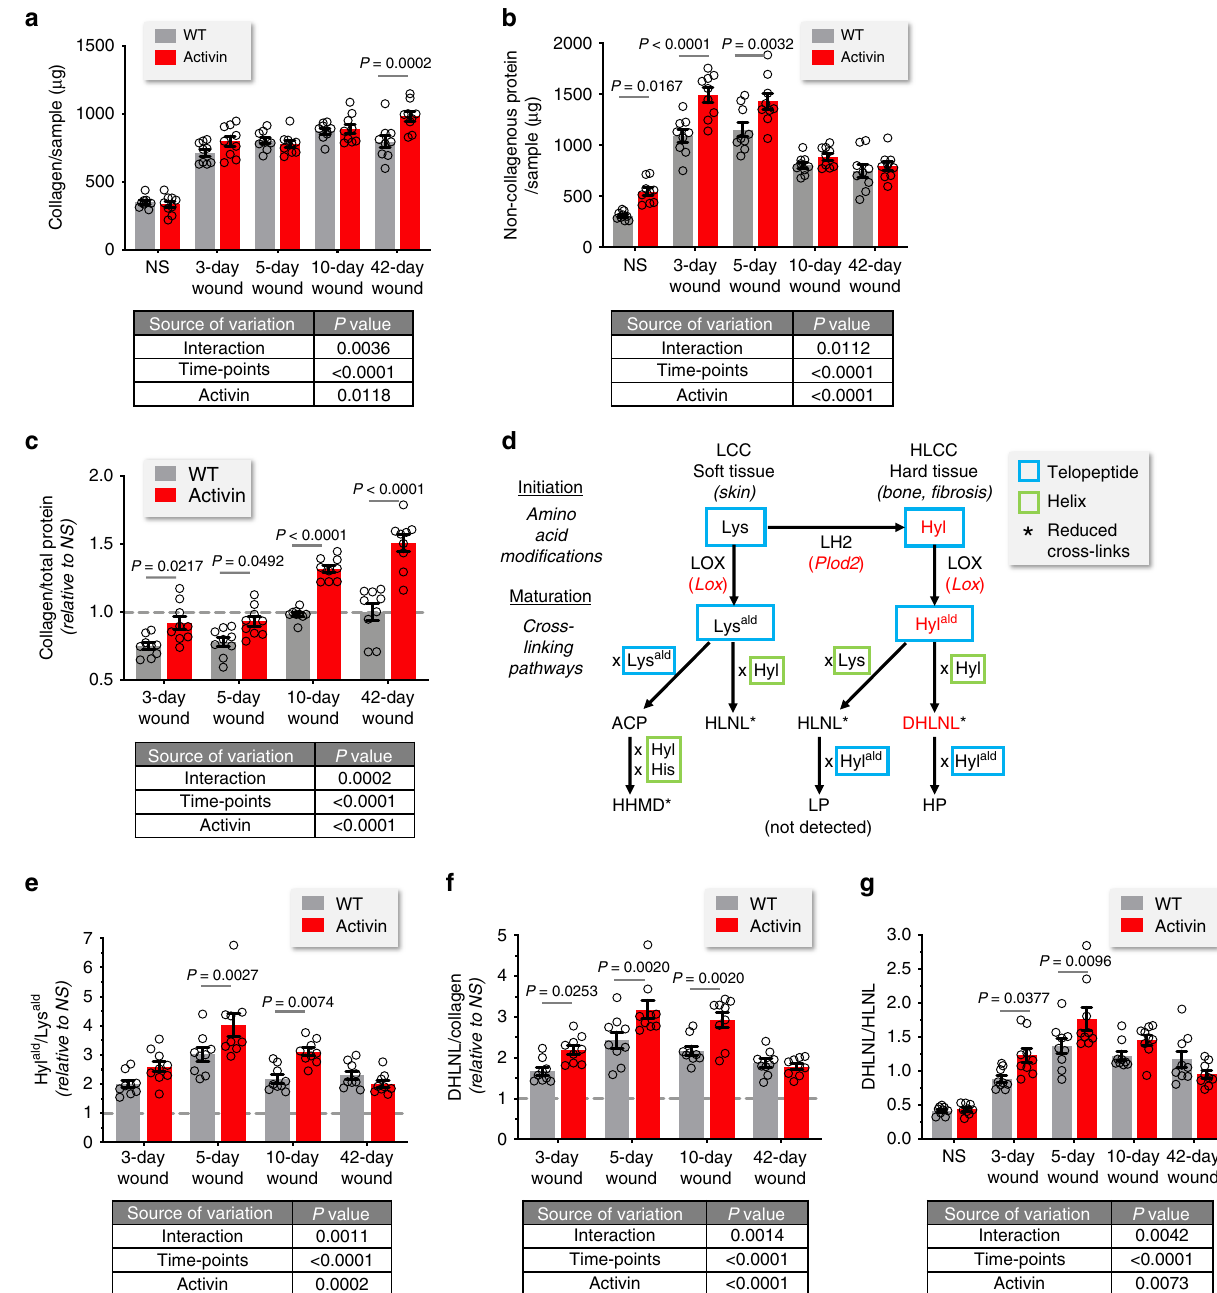
Fig. 7 Activin promotes collagen maturation in healing wounds. Biochemical analysis of collagen and non-collagenous proteins using whole lysate from unwounded skin (NS) and from wounds at day 3, 5, 10, and 42 post-injury. a Amount of total collagen per sample. b Amount of total non- collagenous protein per sample. c Amount of collagen per total protein relative to NS (gray dashed line). d Diagram outlining the collagen cross- linking initiation and maturation pathways (adapted from ref. 79 ), the enzymes that are responsible for the number (LOX) and the pattern (LH2) of the cross-links, and the cross-links quanti fi ed in our analysis. Modi fi cations that are increased in wounds of Act mice are in red. e Hyl ald /Lys ald ratio relative to NS (gray dashed line). f DHLNL/collagen ratio relative to NS (gray dashed line). g DHLNL/HLNL cross-link ratio. Graphs show mean ± SEM and P values; n = 9 biological replicates for mice of both genotypes at all time points; two-way ANOVA and Bonferroni ’ s multiple comparison post hoc tests; results of two-way ANOVA are shown below each graph ( fi rst factor: time point, second factor: activin overexpression). HLCC hydroxylysine aldehyde derived collagen cross-links, LCC lysine aldehyde-derived collagen cross-links, Lys lysine, Hyl hydroxylysine, LH lysyl hydroxylase, LOX lysyl oxidase, Lys ald lysine aldehyde, Hyl ald hydroxylysine aldehyde, ACP aldol condensation product, HLNL hydroxylysinonorleucine, DHLNL dihydroxylysinonorleucine, HHMD histidinohydroxymerodesmosine, LP lysylpyridinoline, HP hydroxylysylpyridinoline. Source data are provided as a Source Data fi le (Fig.